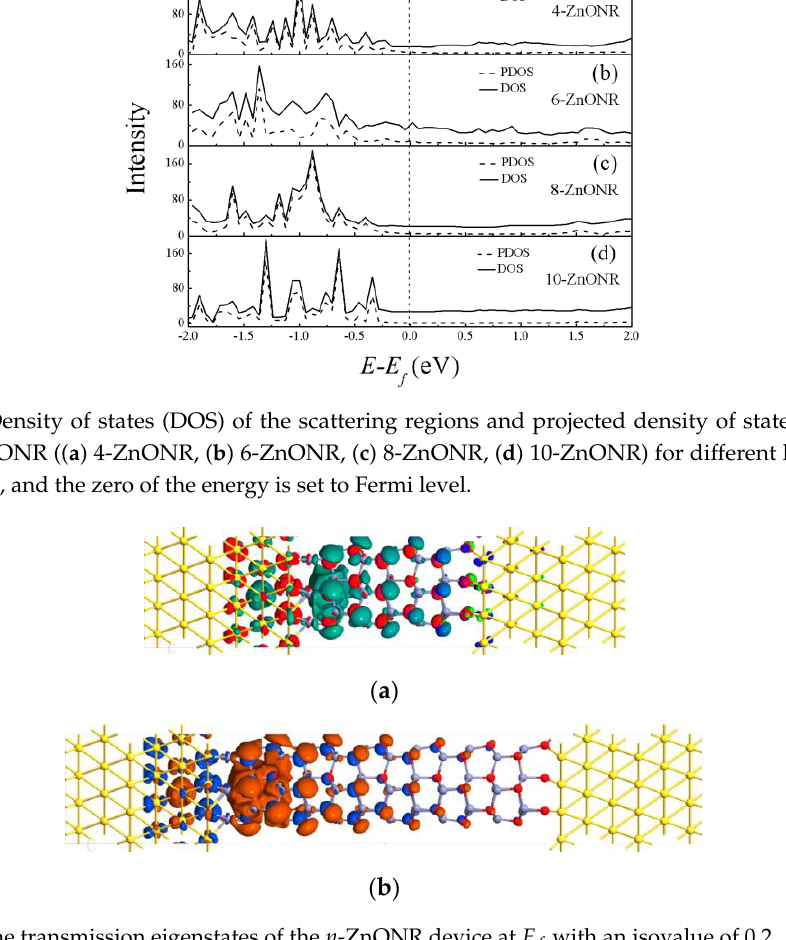
Figure 4. The transmission eigenstates of the n -ZnONR device at 𝐸 𝑓 with an isovalue of 0.2. ( a ) ( n = 4), ( b ) ( n = 10), and the zero of the energy is set to Fermi level.